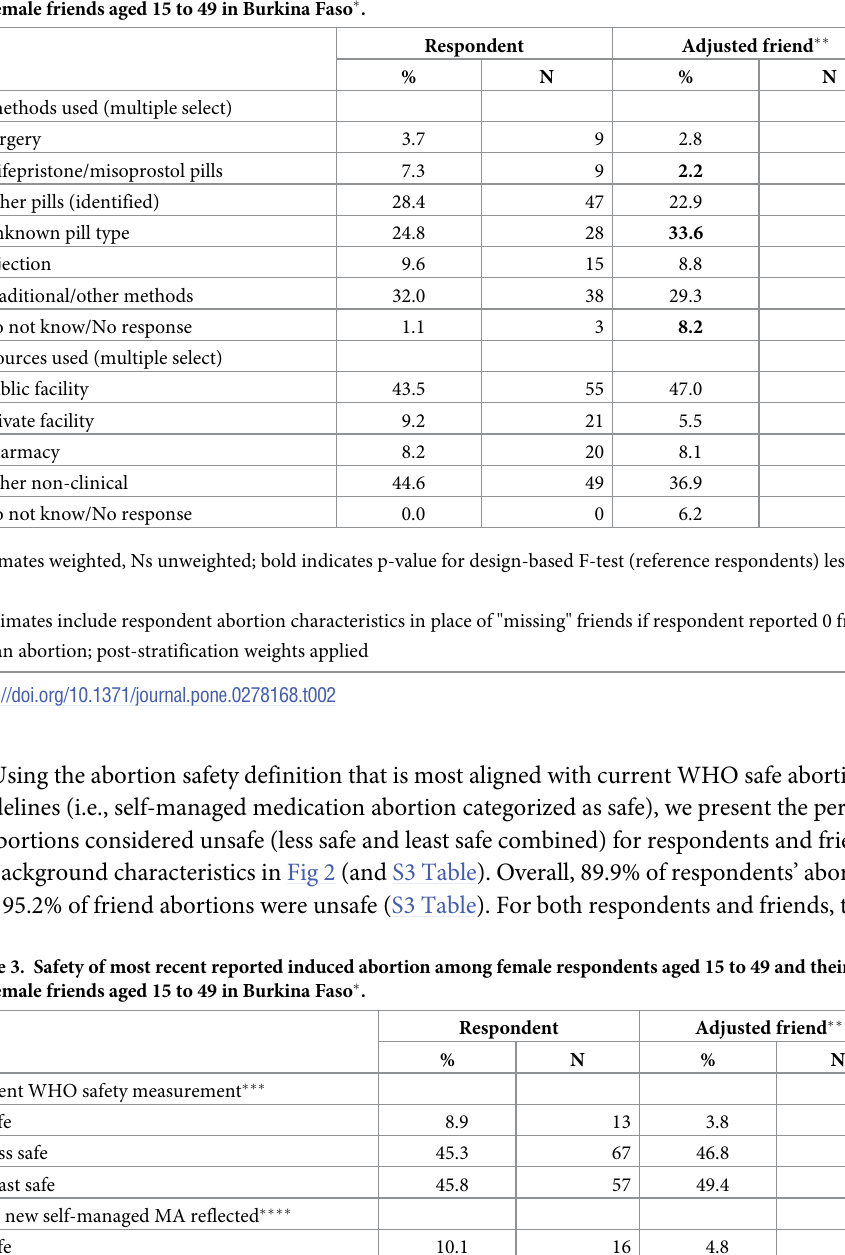
With new self-managed MA reflected ���� Safe